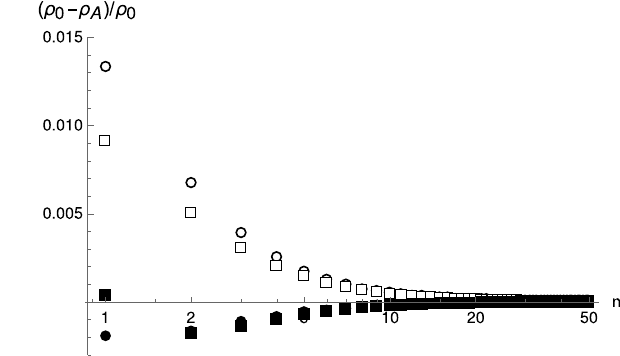
Fig. 2 The discrepancy between the average energy density ρ 0 in the inhomogeneous model and the estimated energy density in the homo- geneous model ρ A for R = 4 M as a function of a number of inhomo- geneous regions. Circles and boxes correspond to different choices of a phase: σ = 1, σ = − 1, respectively. The filled symbols indicate that the outermost shell has higher than ρ 0 density (empty symbols indicate otherwise). The value of ρ A was estimated from the observed gravi- tational mass M of the cluster and the redshift z of outermost objects